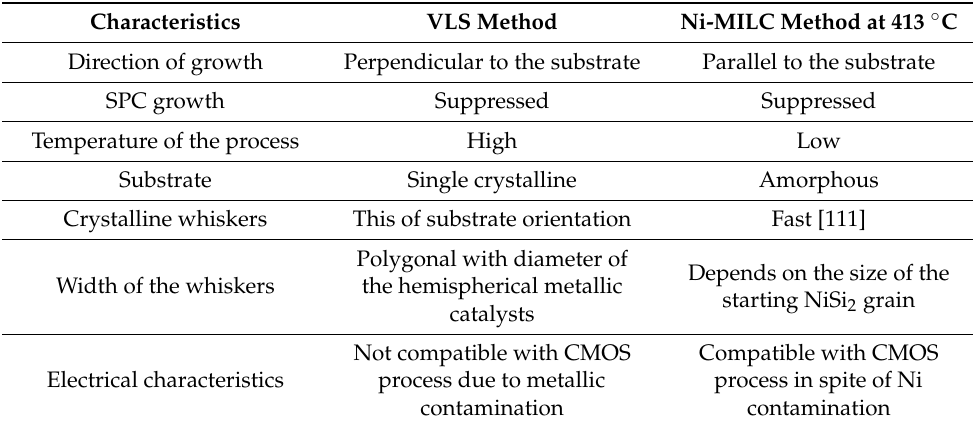
Table 1. Comparison of the Si whiskers grown by the VLS and the Ni-MILC at 413 ◦ C methods.